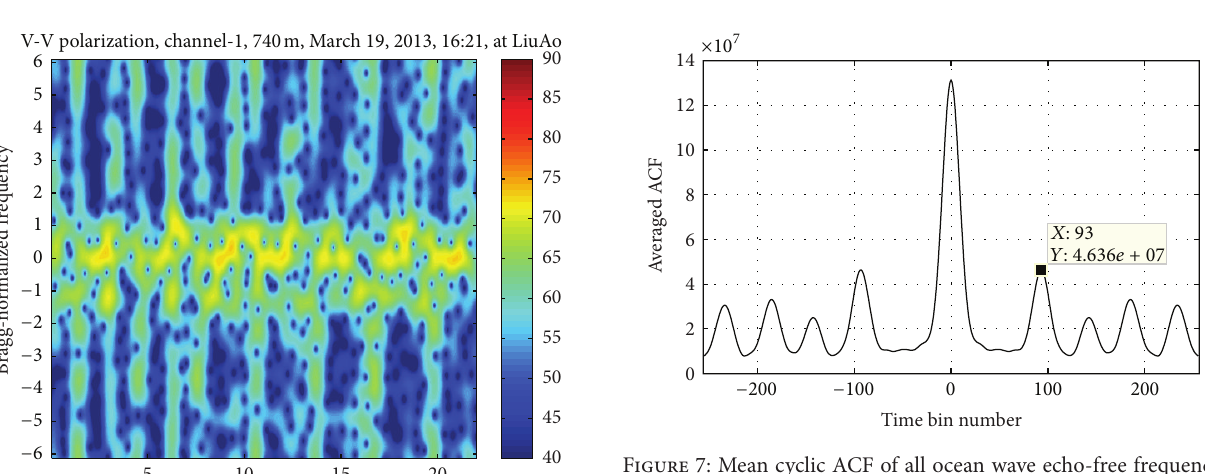
Figure 7: Mean cyclic ACF of all ocean wave echo-free frequency bins in the time-frequency